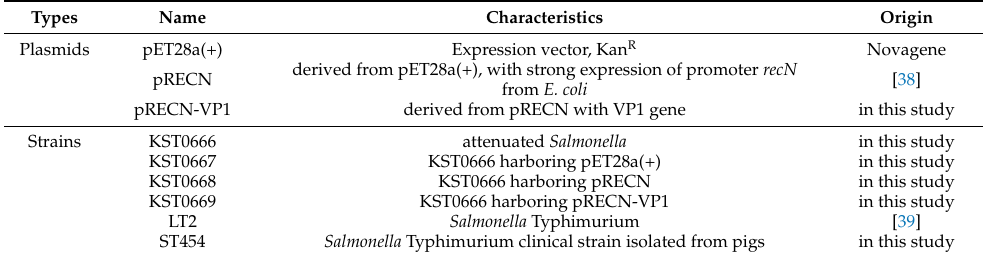
Table 1. Plasmids and strains used in this